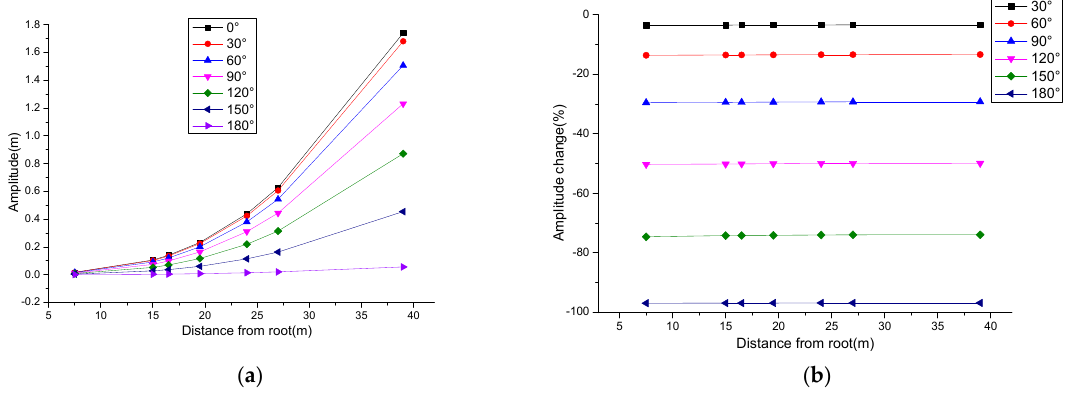
Figure 8. The relationship between the phase difference of exciters and the amplitude of the blade. ( a ) Phase difference of exciters and amplitude of the blade; ( b ) Phase difference of exciters and amplitude change of the blade.